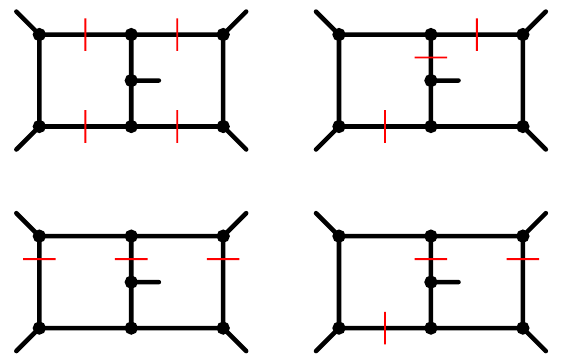
Figure 4 . A spanning set of cuts for performing IBP reduction for the nonplanar double pentagon diagram. A cut propagator is indicated by a red line. There are 11 cuts in total, from applying diagram symmetries to the 4 representative cuts shown